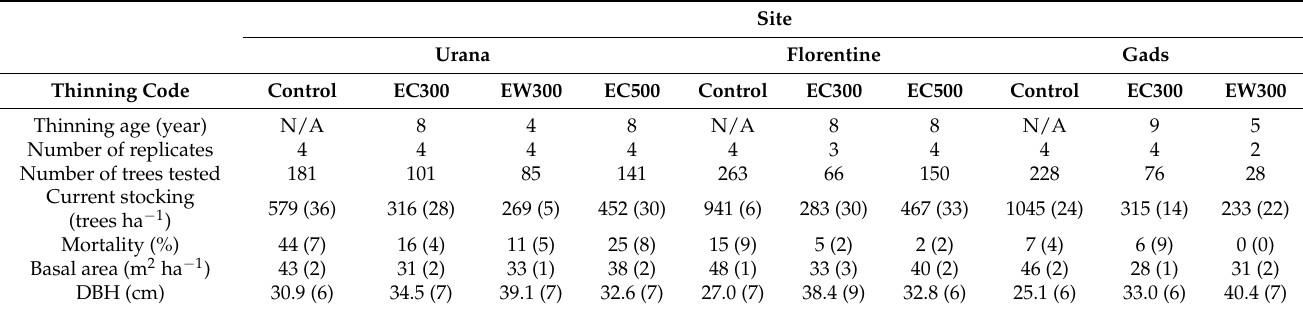
Table 2. Stand characteristics in 2018 for each thinning treatment in the three thinning trials established in Tasmania,